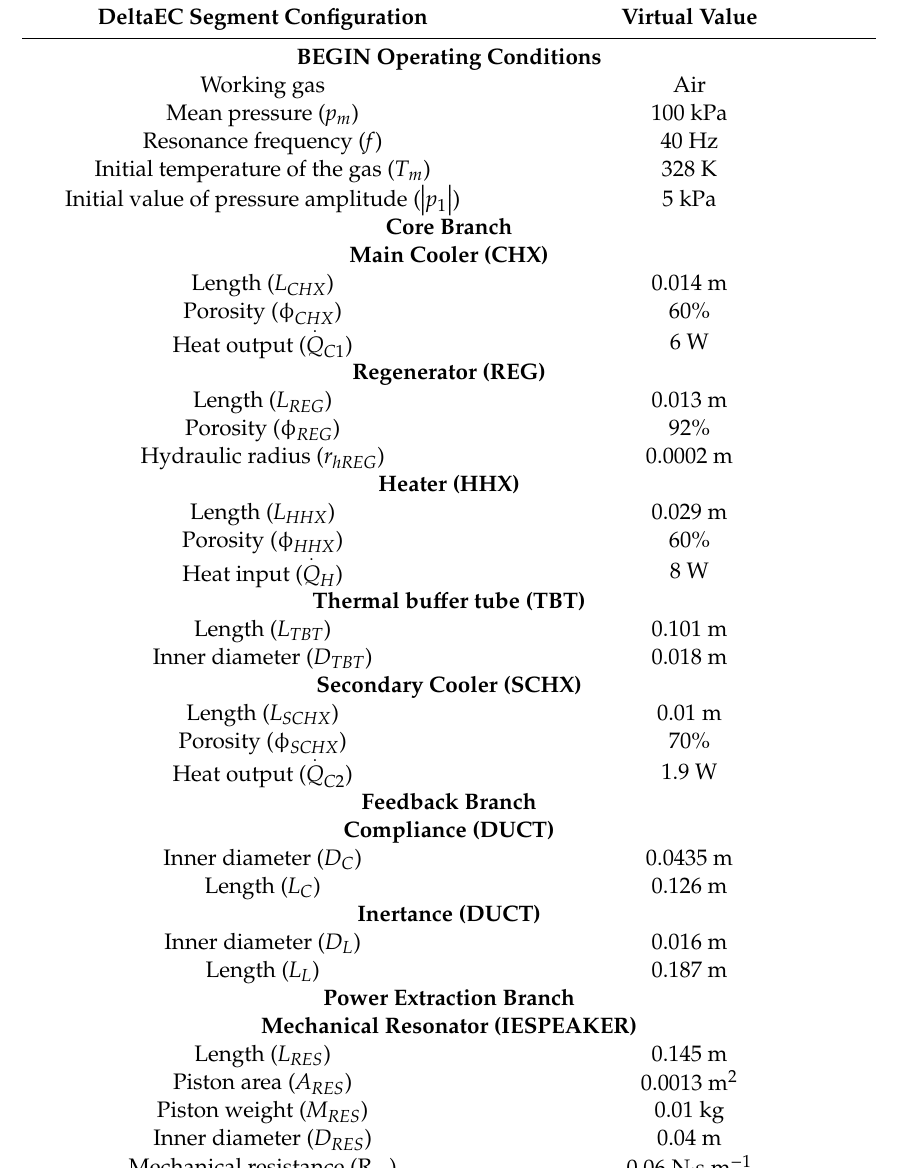
Table 1. Geometry details and operating conditions of the proposed TA-SLiCE model. Design Environment for Low-Amplitude Thermoacoustic Energy Conversion,